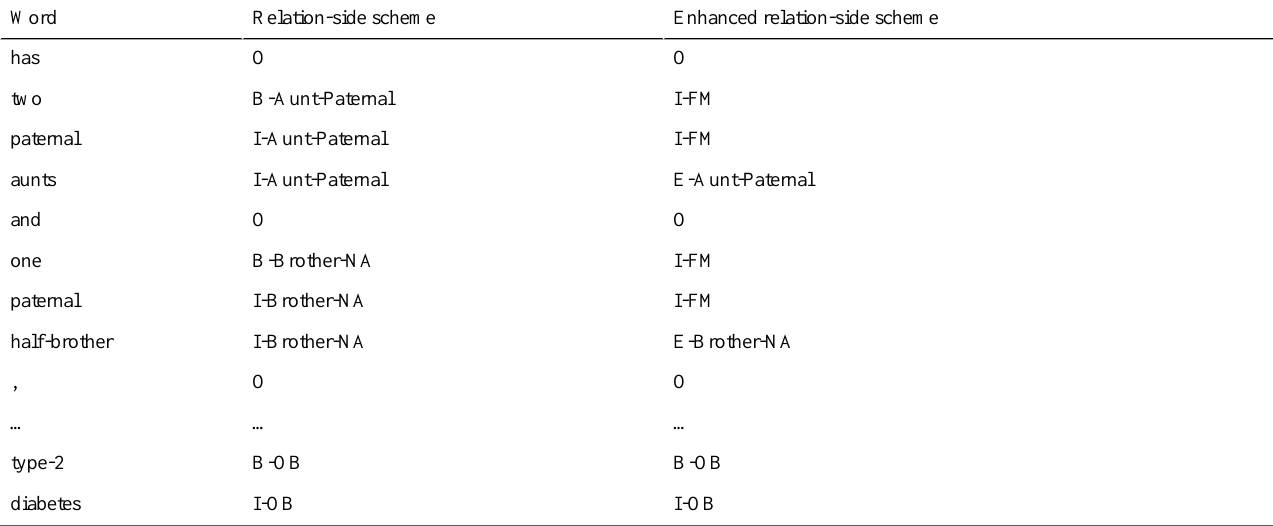
Table 1. An example sentence encoded with the relation-side scheme and enhanced version: “The patient has two paternal aunts and one paternal half–brother, all were diagnosed with type-2 diabetes.”